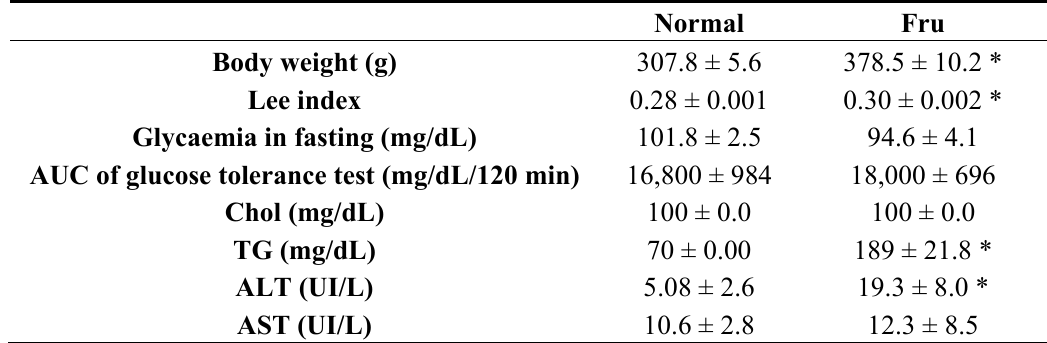
Table 1. Effect of the FOS-fraction from P . decompositum on final weight and biochemical parameters in male Wistar rats with 12 weeks fructose